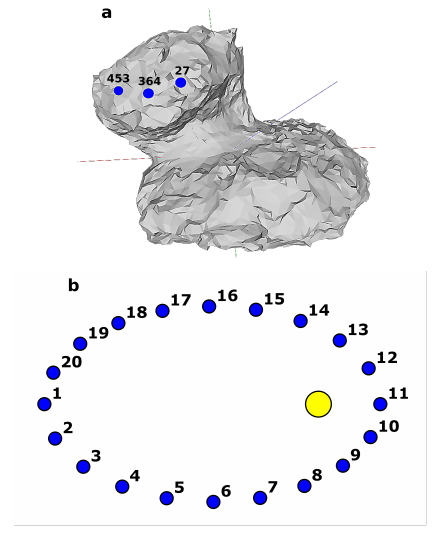
Figure 2. Basic parameters of numerical simulation: a) points in dif- ferent parts of the MA’AT region and b) orbital points for numerical simulations